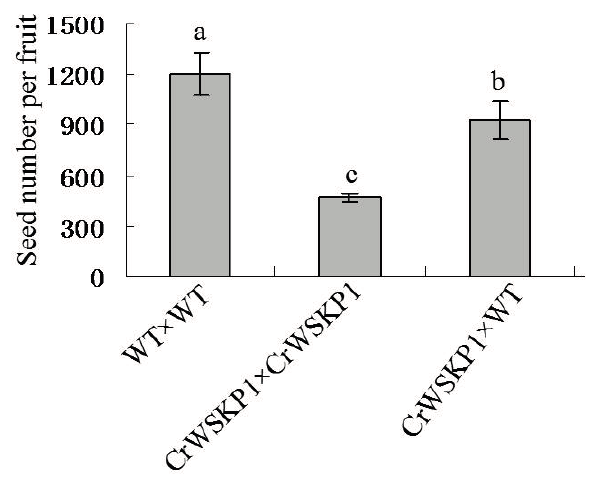
Figure 5. Seed number per fruit of CrWSKP1 transgenic tobacco after self- or cross-pollination. The vertical bars represent standard deviation (±SD) of three biological replicates. a,b,c represent significant difference using the LSD test at p ≤